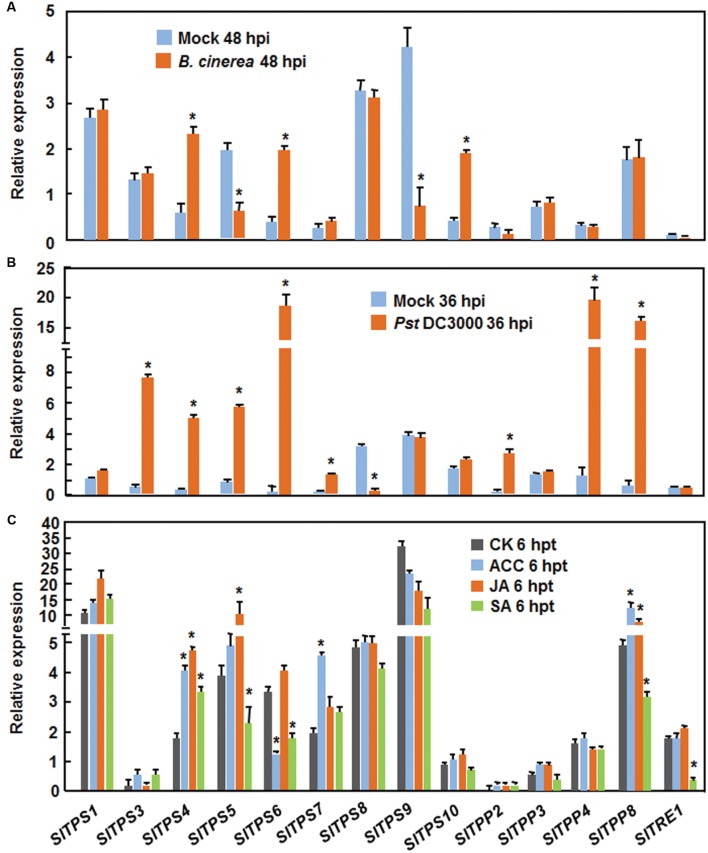
Expression of selected SlPTSs, SlTPPs, and SlTRE1 in responses to infection with Botrytis cinerea or P. syringae pv. tomato DC3000 and to treatments with defense signaling hormones.
(A) Expression of selected trehalose-related genes in response to B. cinerea. Four-week-old plants were inoculated by foliar spraying with spore suspension of B. cinerea or with same volume of buffer as a mock control and leaf samples were collected at 48 h after inoculation for analysis of gene expression. (B) Expression of selected trehalose-related genes in response to Pst DC3000. Four-week-old plants were inoculated by vacuum infiltration with suspension of Pst DC3000 or with 10 mM MgCl2 solution as a mock control and leaf samples were collected at 36 h after inoculation for analysis of gene expression. (C) Expression of selected trehalose-related genes in response to defense signaling hormones. Tomato plants were treated by foliar spraying of 100 μM SA, 100 μM MeJA, 100 μM ACC or similar volume of solution as a control and leaf samples were collected after 6 h for analysis of gene expression. Expression data were normalized with the value of a reference SlActin gene and relative expression was shown as folds of the SlActin expression level. Data presented are the means ± SD from three independent experiments and ∗ above the columns indicate significant differences at p < 0.05 level between the pathogen-inoculated or hormone-treated plants and the mock-inoculated/treated plants.